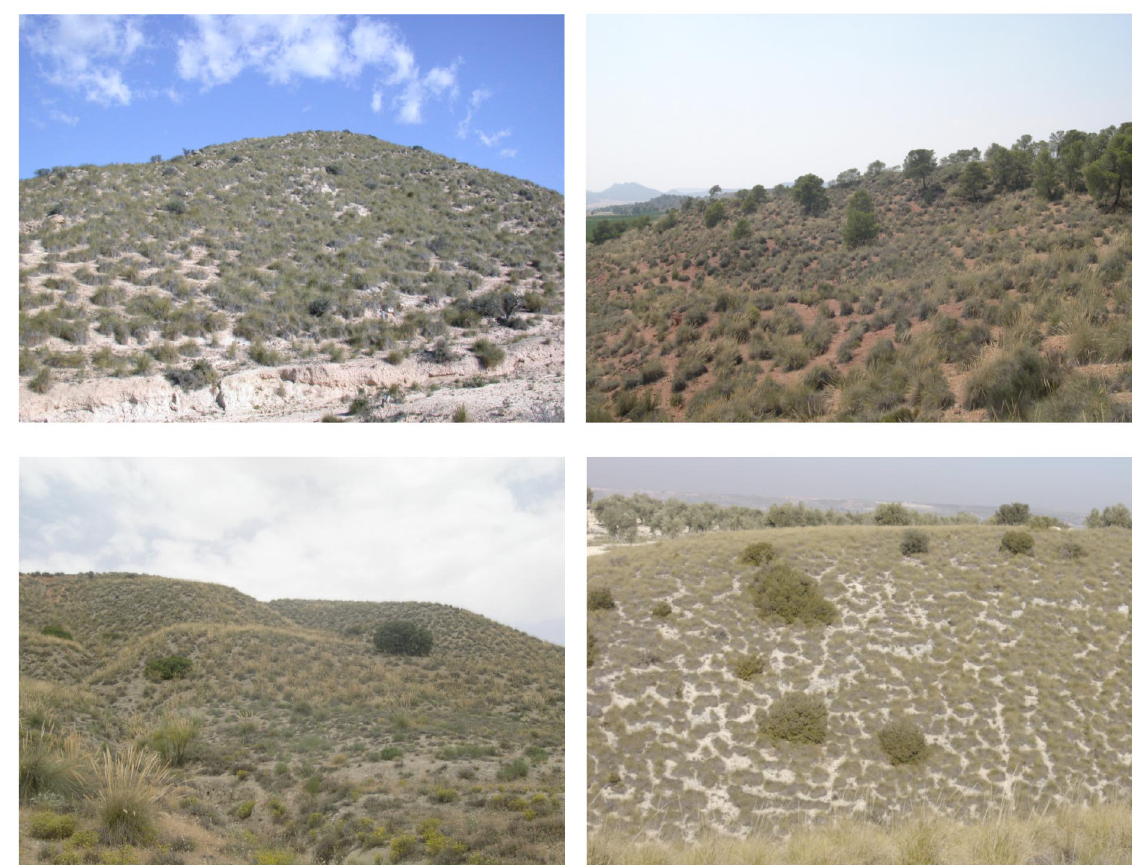
Fig. 1. View of different Stipa tenacissima steppes from Central and South-East Spain, showing the typical two-phase mosaic of bare ground areas and S. tenacissima tussocks and the presence of sprouting shrubs such as Quercus coccifera and trees like Pinus halepensis